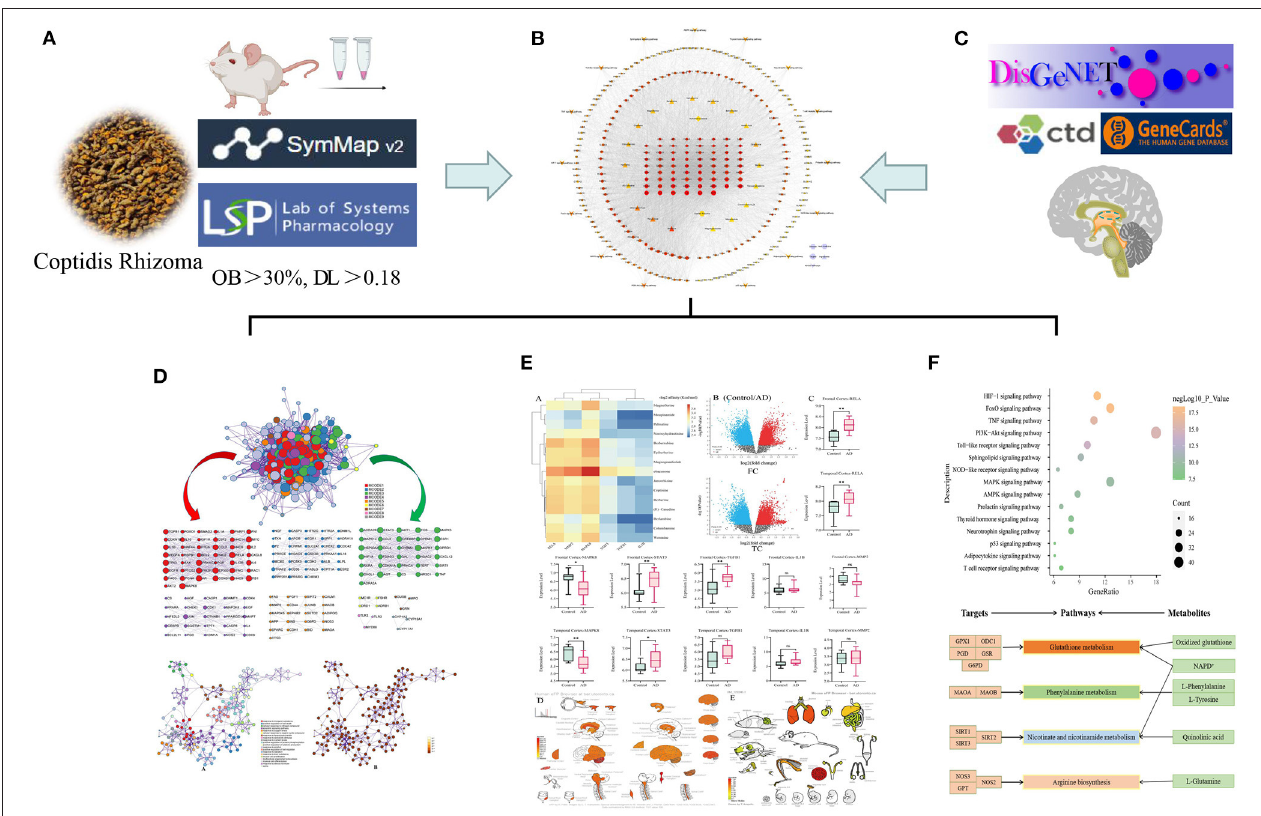
FIGURE 1 | A comprehensive strategy diagram for CR in AD treatment. (A) Chemical composition collections for CR. (B) Compositions-targets network diagram. (C) Collection of genes related to AD. (D) Gene ontology enrichment (GO). (E) Molecular docking and analysis of core gene expression. (F) Pathway enrichment